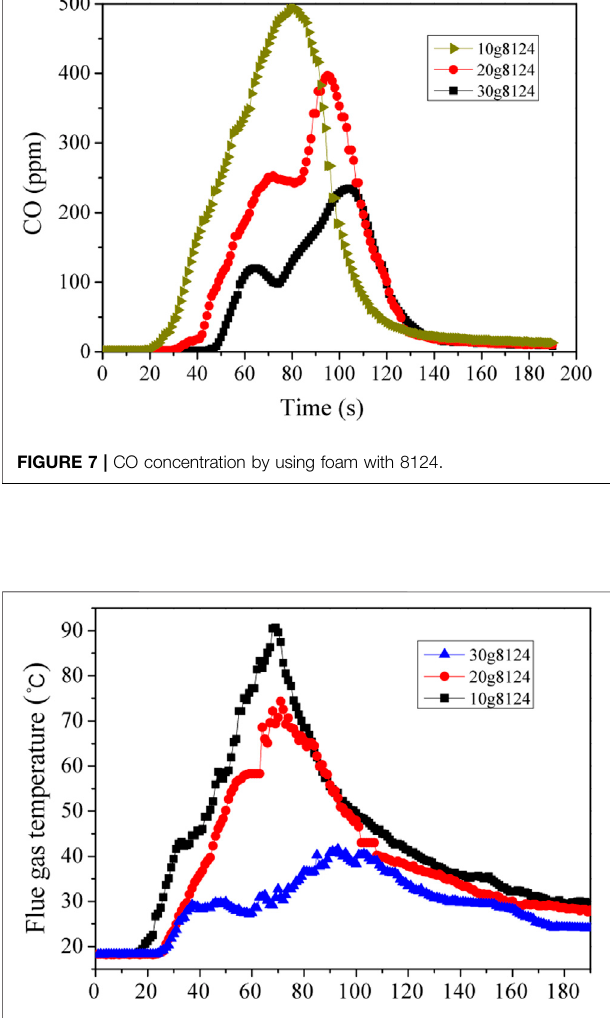
Figure 7 was the CO concentration change curve by using foam with water-soluble fl ame retardant 8124.